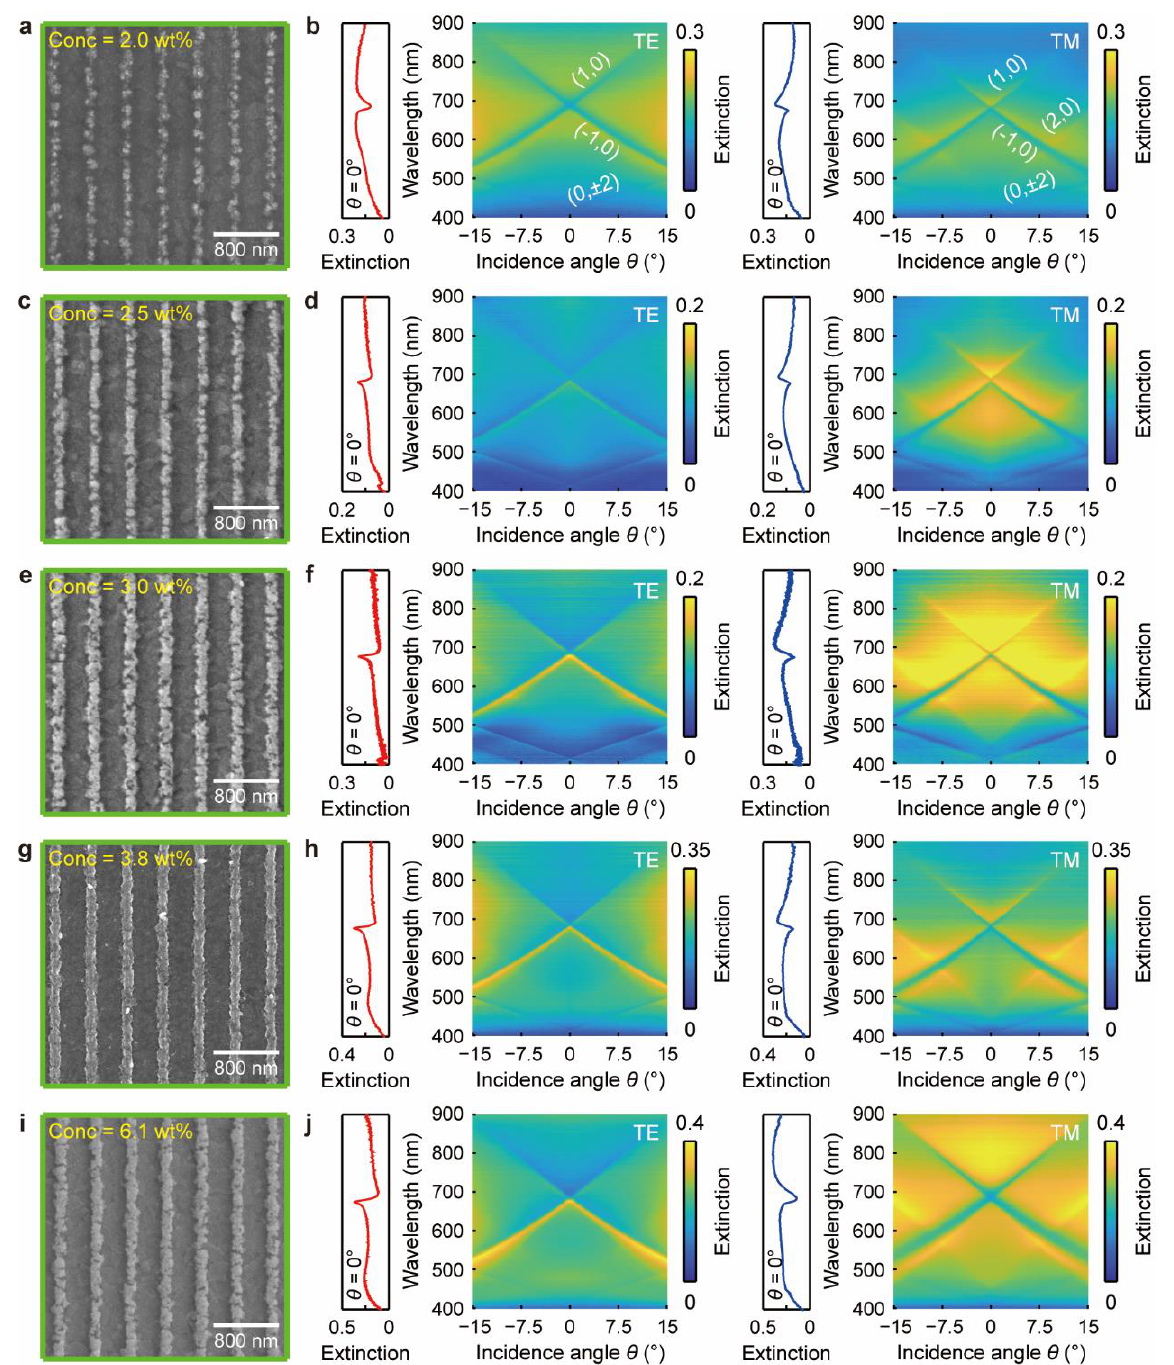
Figure 3. The morphologies and the optical responses of the Ag grating slabs tuned by the AgNO 3 concentrations. ( a – j ) The SEM images and the corresponding angle-resolved TE and TM extinction spectra of the Ag grating slab structures fabricated using the AgNO 3 concentrations of Conc. AgNO3 = 2.0, 2.5, 3.0, 3.8, and 6.1 wt. %.